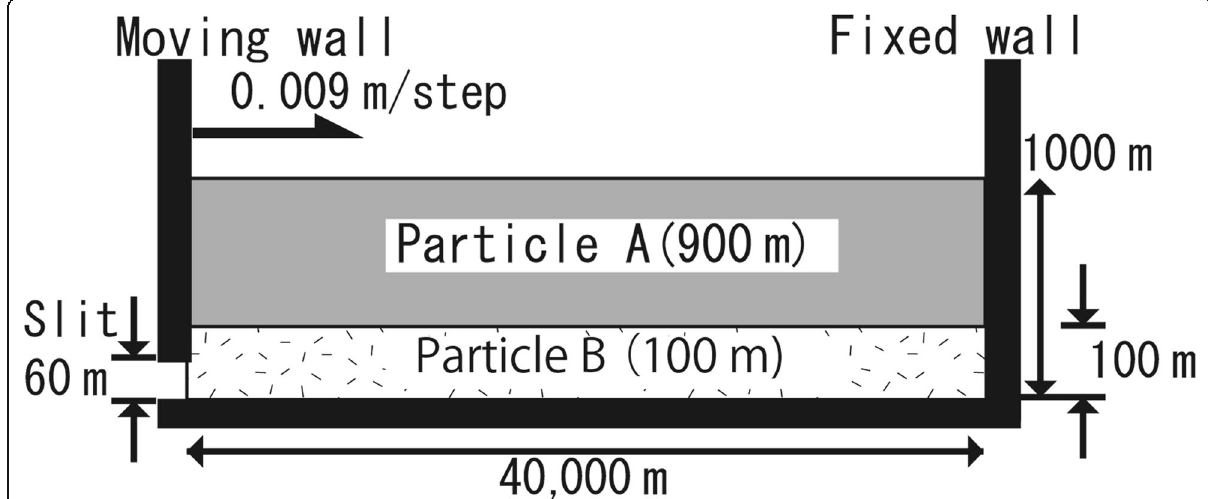
Fig. 1 Setup to perform the numerical simulations. The upper layer (100 – 1000 m) comprises particle A, whereas the bottom layer (0 – 100 m) comprises particle B. The left side wall pushes the particles to the right side at a small rate of displacement (0.009 m for each calculation time step). The moving wall has a slit (0 – 60 m) to produce a detachment (décollement) within the bottom layer. The shear drag factor of particle B increases from the left-hand side to the right-hand side in response to the displacement of the moving wall (modified after Miyakawa et al. 2010)